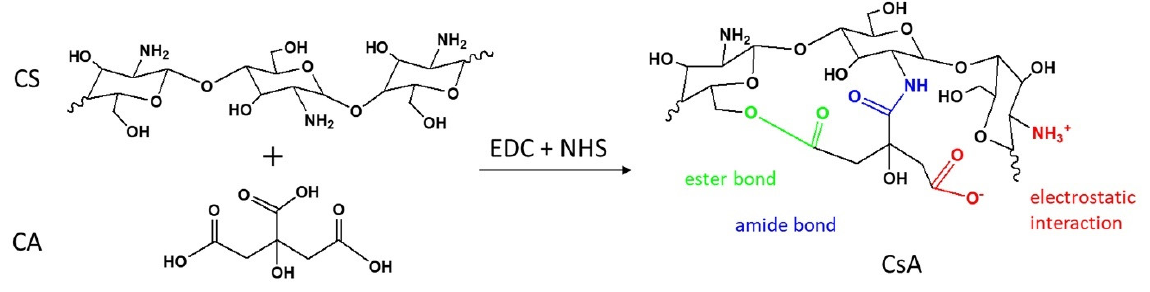
Figure 1. The CS covalent functionalization with CA using the EDC/NHS coupling system.